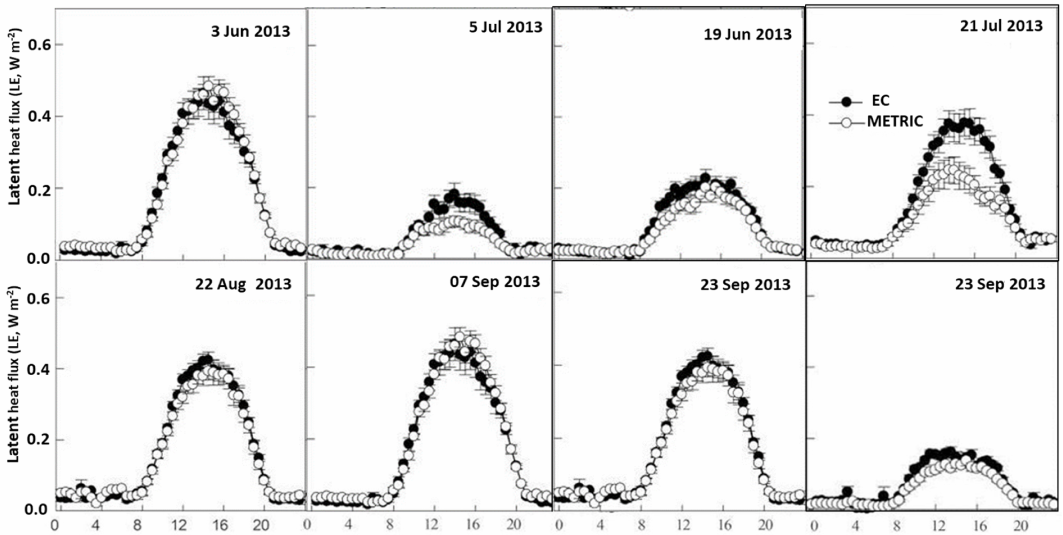
Figure 9. Comparative assessment of eddy covariance (EC) flux tower measured against the METRIC-estimated latent heat flux (LE, Wm − 2 ) over the study period. (The values on the x axis are hour of the day in local time.) data for the studied Landsat-8 date of